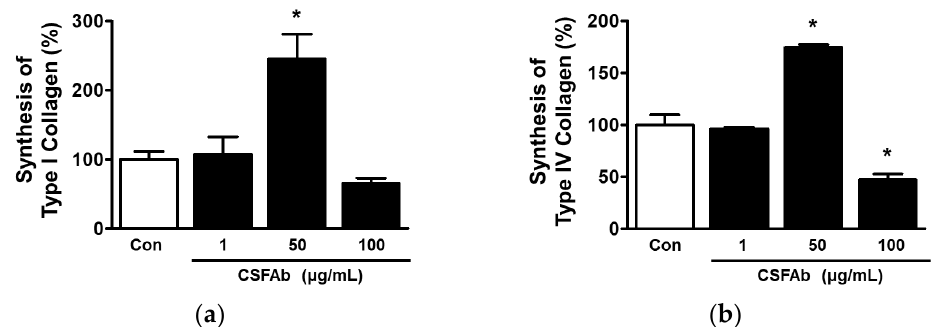
Figure 4. Effects of Caragana sinica absolute on type I and type IV collagen syntheses in HaCaT cells. Cells were treated with or without Caragana sinica flower absolute (CSFAb; 1–100 μg/mL) for 48 h. Collected conditioned media were treated with anti-type I ( n = 3; ( a )) or anti-type IV collagen antibody ( n = 3; ( b )) and subjected to sandwich ELISA. Results are expressed as mean percentages ± SEMs of untreated controls (Con). * p < 0.05 vs. untreated controls.